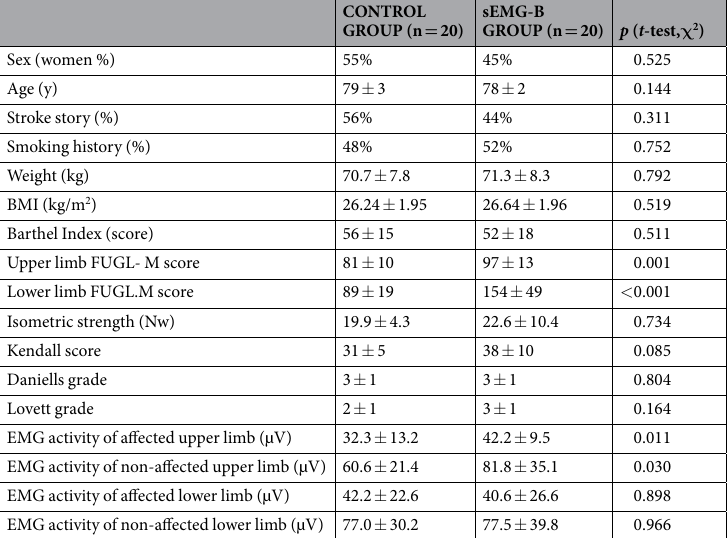
Table 1. Sociodemographic and clinical baseline characteristics of both control and sEMG-B groups. Data represent Mean ± SD. BMI: body mass index. FUGL-M: Fugl-Meyer score. EMG activity represents the average EMG activity of a 15-minute session, in µ V, analysed with the Neurotrans Myoplus 2 Pro system. Differences between groups were analyzed by Student’s t